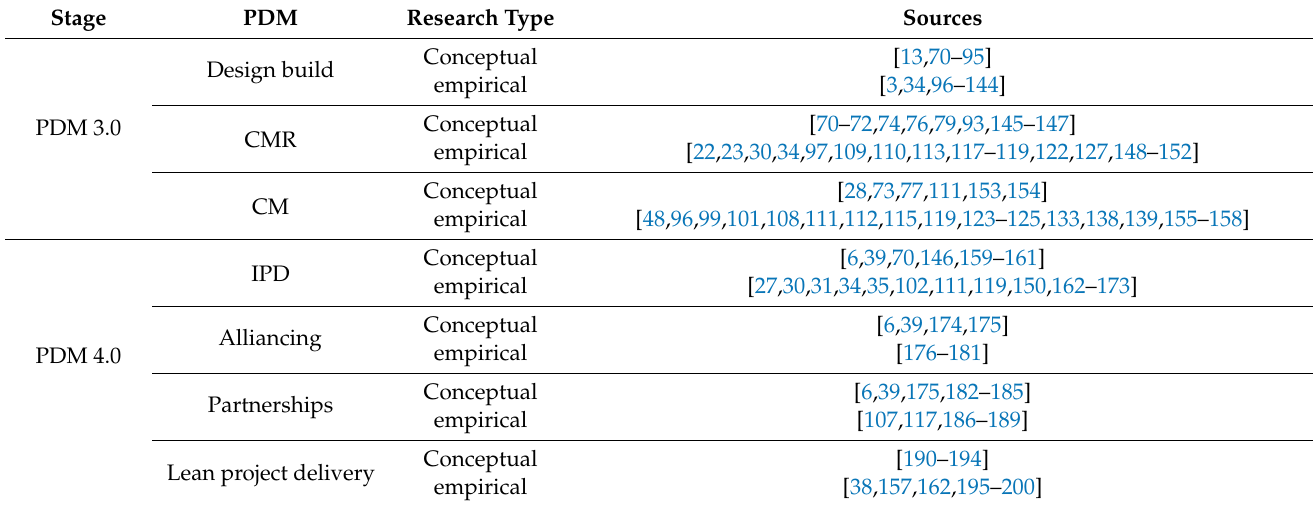
Table 1. Overview of people-centered innovations and mass production (PDM 3.0) and PDM 4.0. Stage PDM Research Type